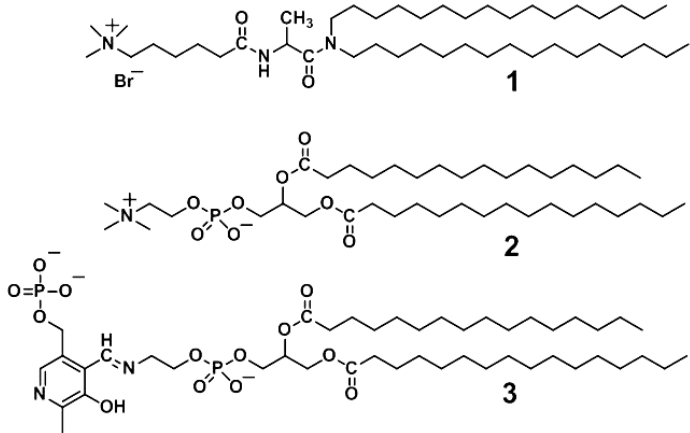
Figure 3. Molecular components of the bio-inspired molecular